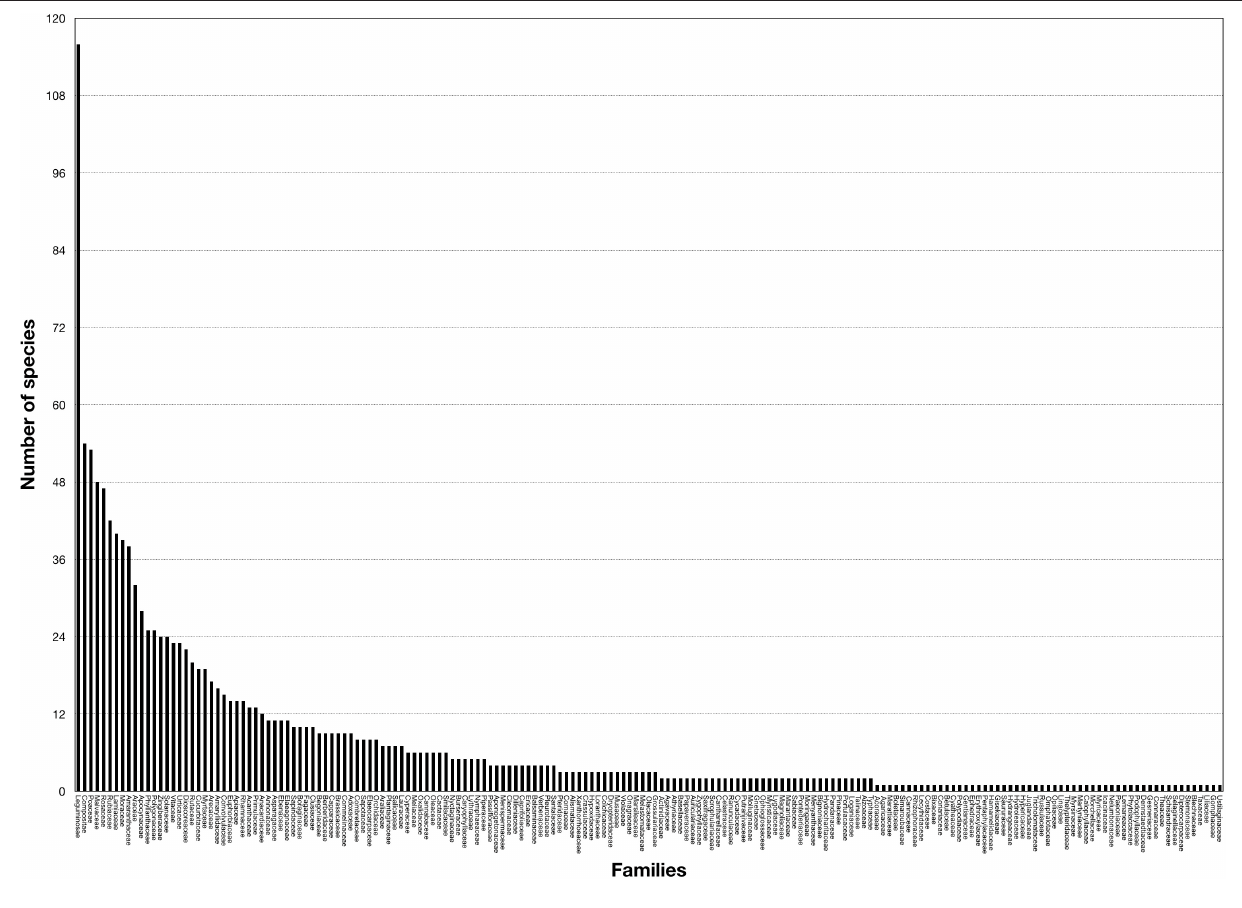
FIGURE 2 | Distribution of species across